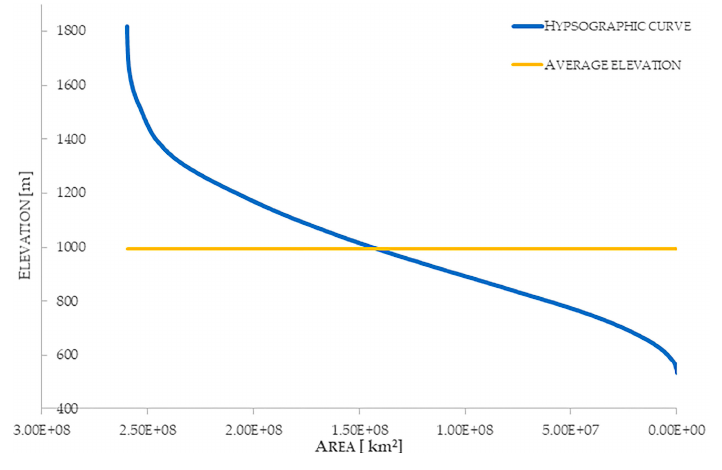
Figure 3. Hypsographic curve.